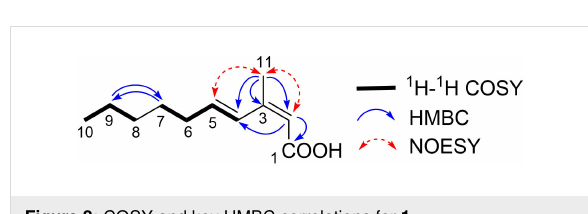
Figure 2: COSY and key HMBC correlations for 1